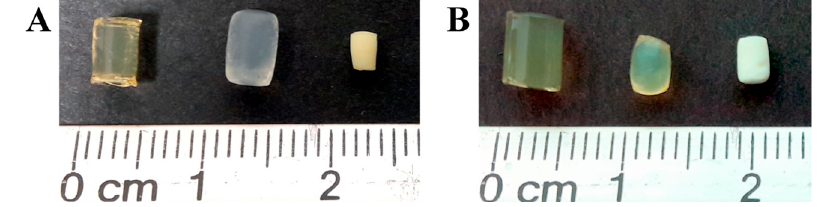
Figure 1. Materials formed from the Cs-IL solutions: ( A ) CsE and ( B ) CsB. From left to right: ionogel, acetogel and aerogel.